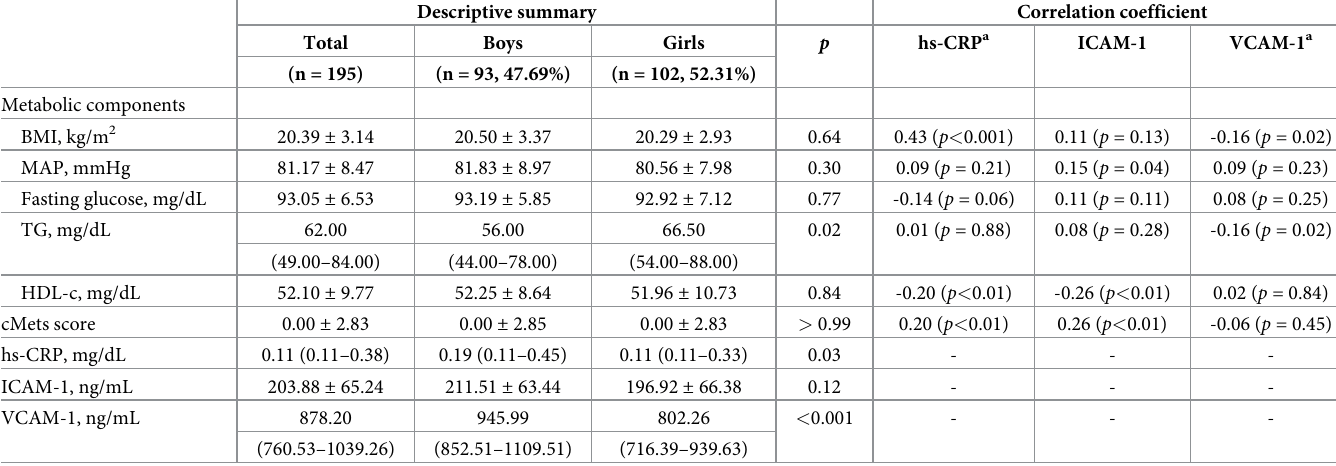
Table 3. Descriptive statistics and correlation coefficients between metabolic syndrome components, scores, and markers of inflammation and endothelial dysfunction.